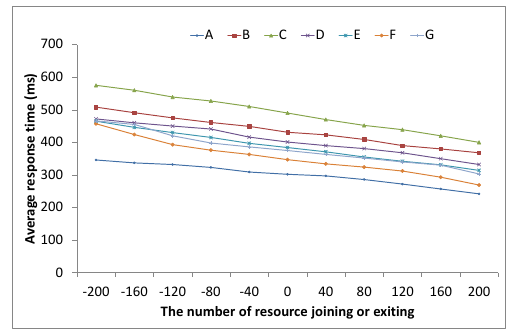
Fig. 1. Energy with resource joining or exiting.